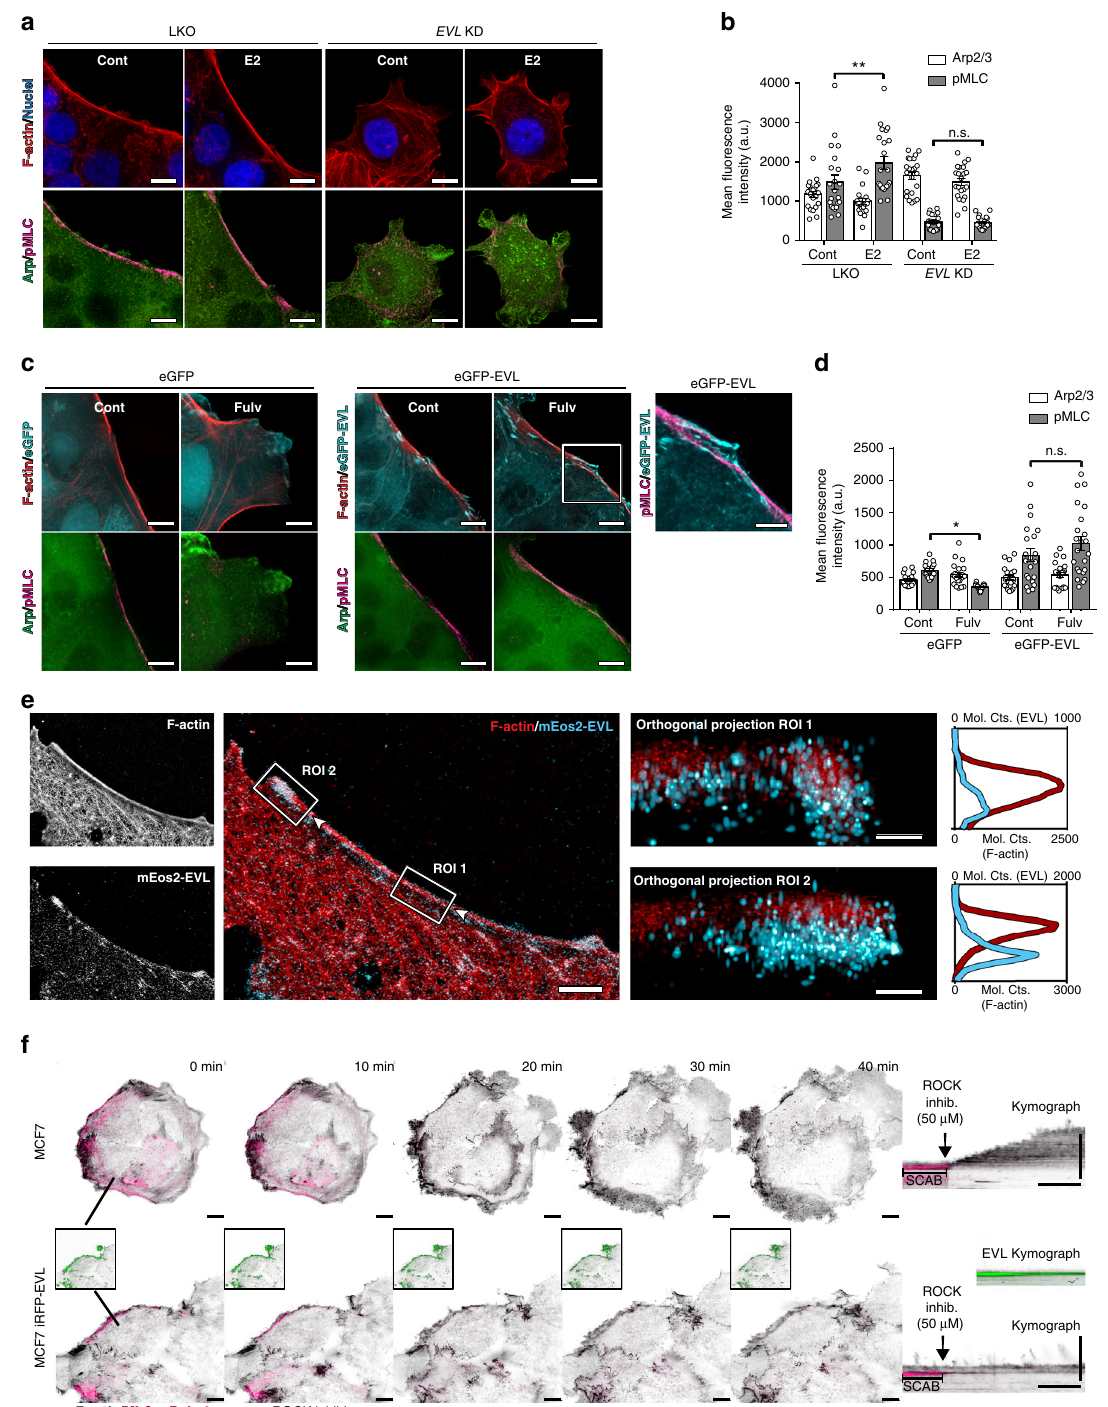
Imaging: Tumors were imaged using a ×20 Plan Apo 0.75NA Nikon objective on a Nikon Ti-E inverted microscope equipped with a Hamamatsu ORCA-Flash 4.0 V2 cMOS camera, motorized stage, and maintained in focus using Nikon Perfect Focus System. Large composite images of whole tumor sections were generated by digital stitching using Nikon Elements. Tumor sections that were damaged or that exhibited high degree of in fl ammatory cell in fi ltration were excluded from the analysis. LII analysis . Breast cancer TMAs: Two independent breast cancer TMA sets were used in this analysis: (TMA#1) Cancer Diagnostics Program (CDP) BCP TMA from